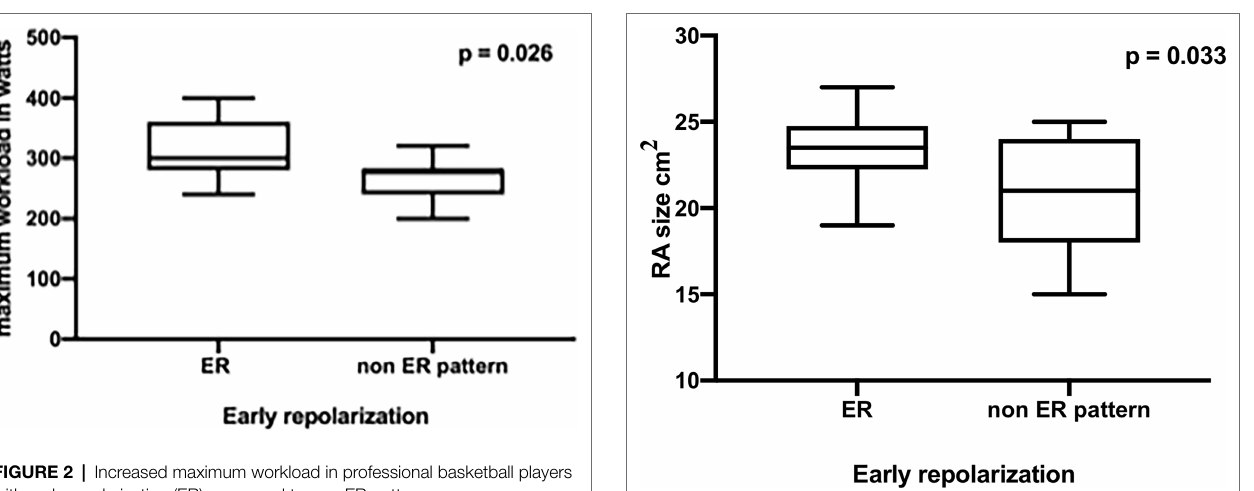
FIGURE 2 | Increased maximum workload in professional basketball players with early repolarization (ER) compared to non-ER